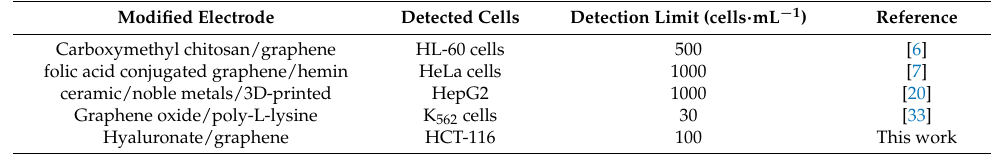
Table 1. Comparison of this work with other reported